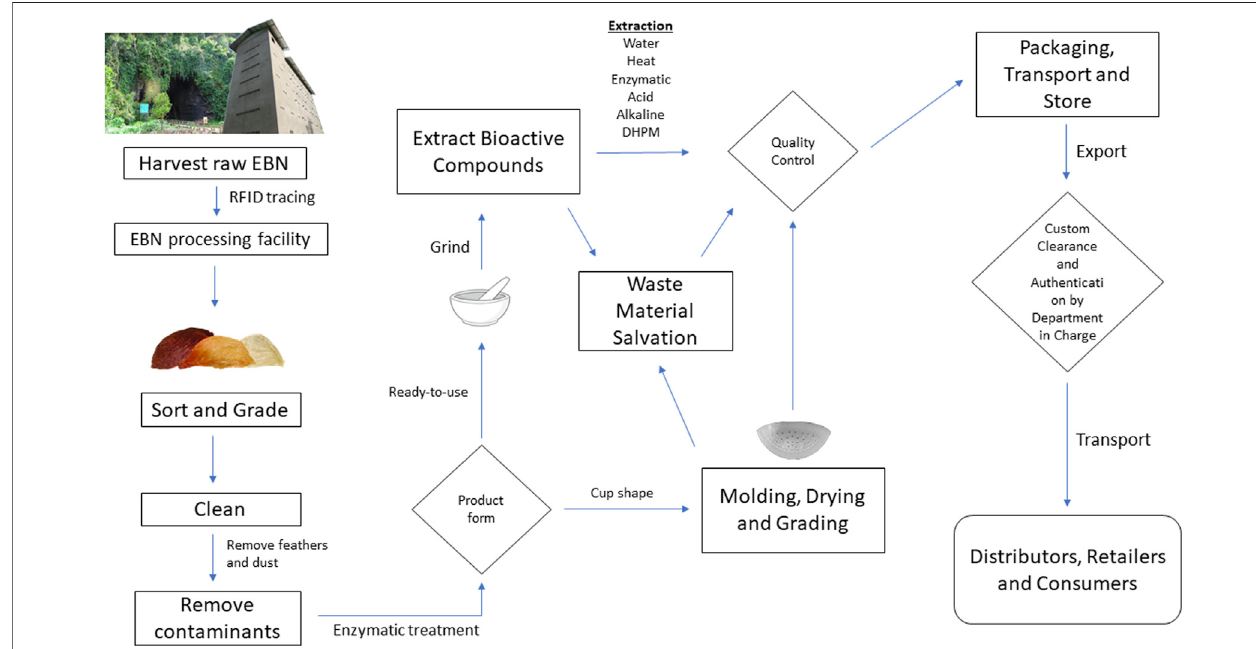
FIGURE 1 | Schematic fl owchart of EBN industry.